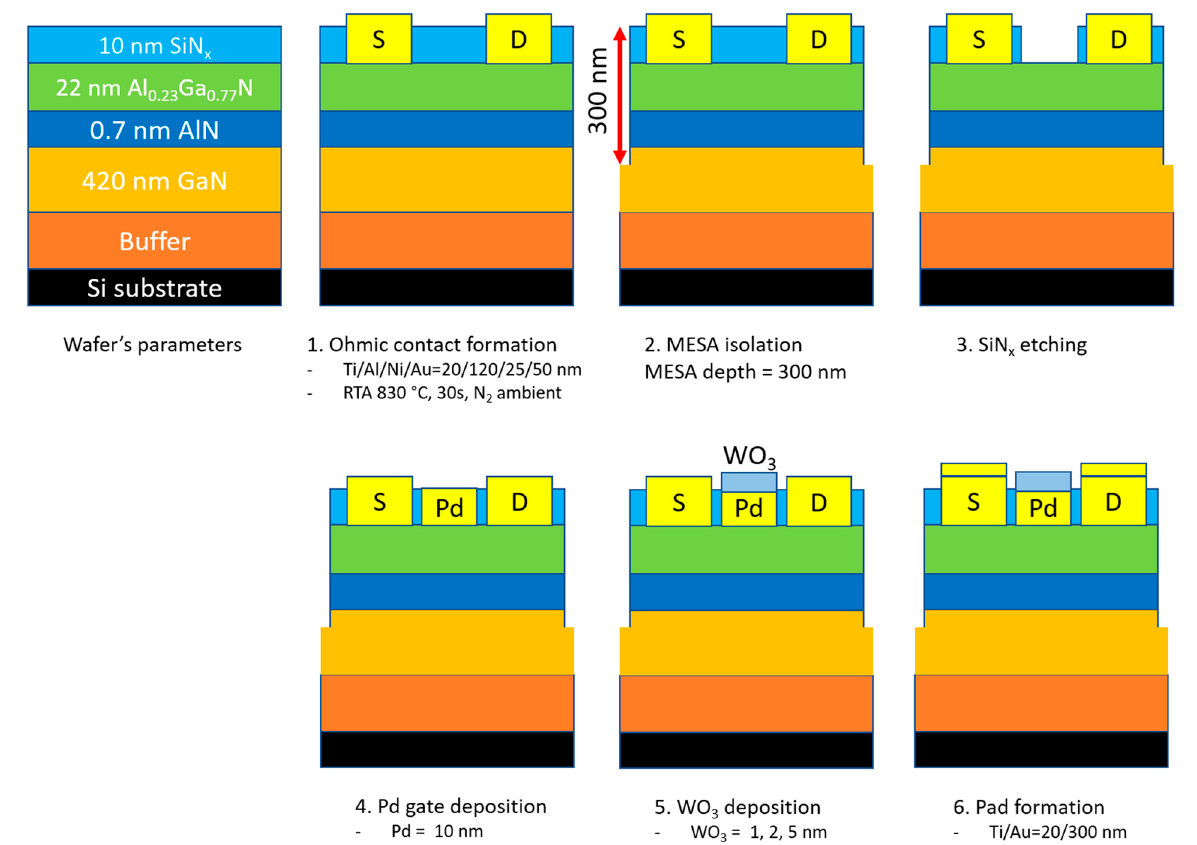
Figure 1. The fabrication process of the Pd-AlGaN/GaN HEMT sensor.